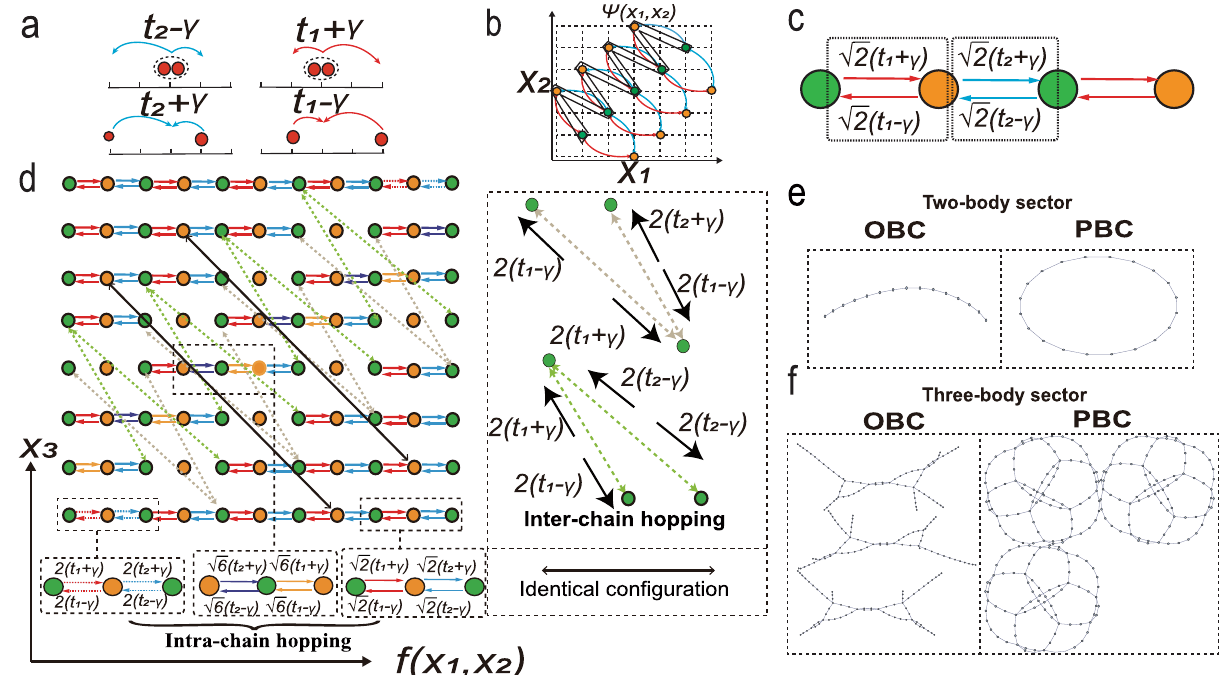
Fig. 1 Representations of models for the Hamiltonian in Eq.(1) in the real space and the effective graph. Sketch of effective models from correlated hoppings in Eq. (1). a The four asymmetric two-body hoppings in our interacting model [Eq. (1)], non-Hermitian whenever γ ≠ 0. b Two-boson con fi gurations ( x 1 , x 2 ), which are non-trivially coupled form a 1D subspace represented by a non-Hermitian effective Su-Schrieffer-Heeger (SSH) model c of 2 L − 5 (see methods), where L is the number of sites in the physical OBC chain. d Effective 2D lattice for a 3-boson OBC subspace, which comprises an array of non-Hermitian SSH chains that are non-locally coupled by inter-chain hoppings (brown and green dashed double arrows), with certain physically identical con fi gurations (black solid double arrows) (( X ( x 1 , x 2 ), x 3 ) and permutations) identi fi ed. See Supplementary Note 1 for details of the effective 2D lattice. The labeled “ intra-chain hoppling ” is induced by bosonic statistics (see explanations in Supplementary Note 1). The “ identical con fi guration ” as the black double arrow is explained in the “ Methods ” section. e , f The Hilbert space connectivity graphs of H in the 2 and 3-boson sectors for L = 15, demonstrating non-trivial modi fi cations to the graph structure from open boundary condition (OBC) to periodic boundary condition (PBC) beyond two